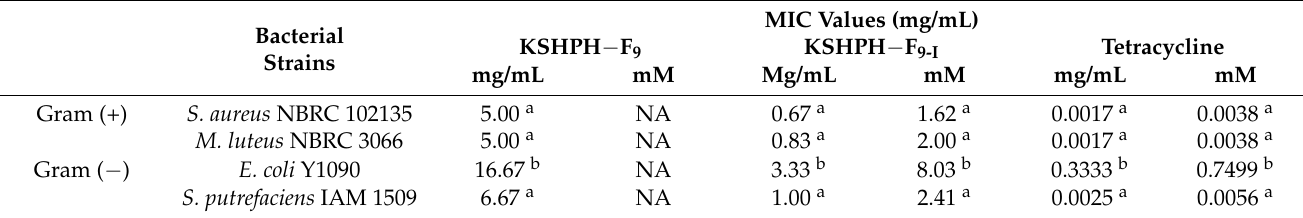
Table 3. MIC values of antibacterial peptides against bacteria strains.